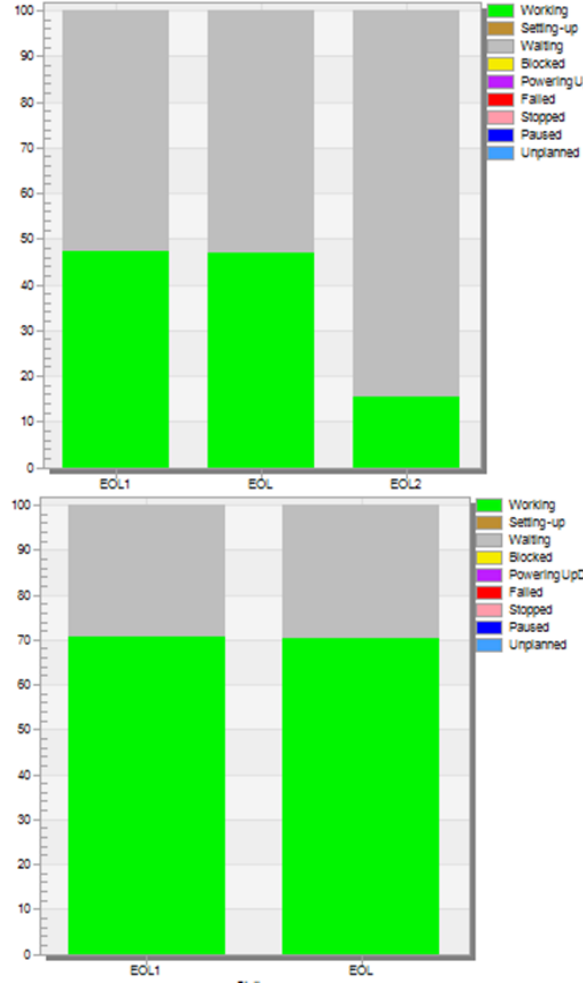
Figure 7: Graph of utilization before modification and after modifica- tion